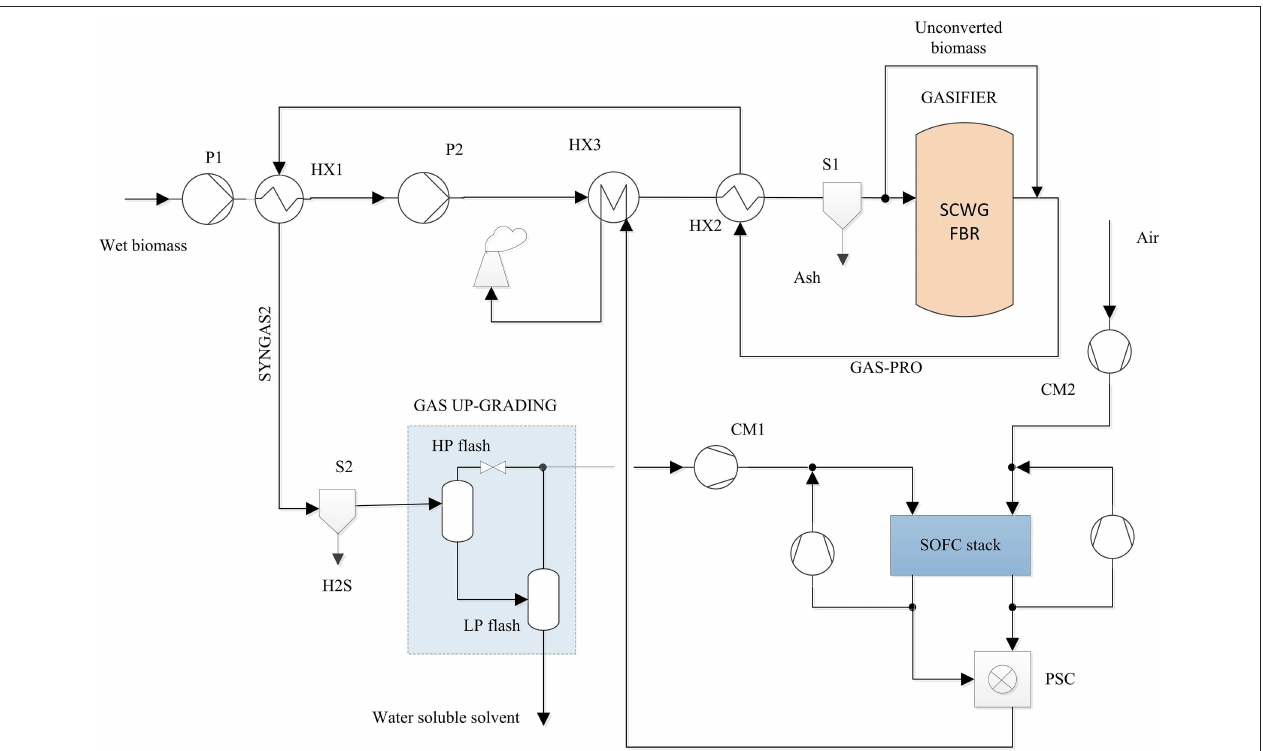
FIGURE 2 | Layout of the supercritical water gasification (SCWG)-solid oxide fuel cell (SOFC) integrated system.